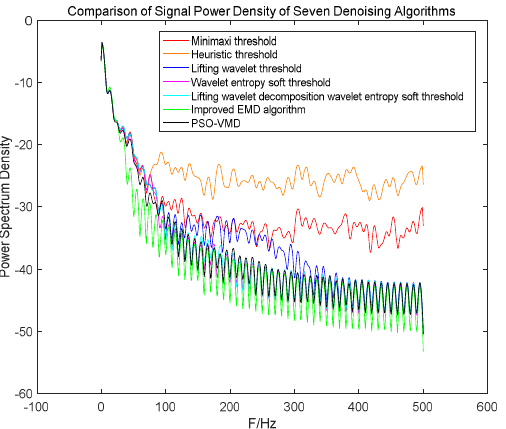
Figure 11. Comparison of the signal power spectrum of the seven denoising algorithms.